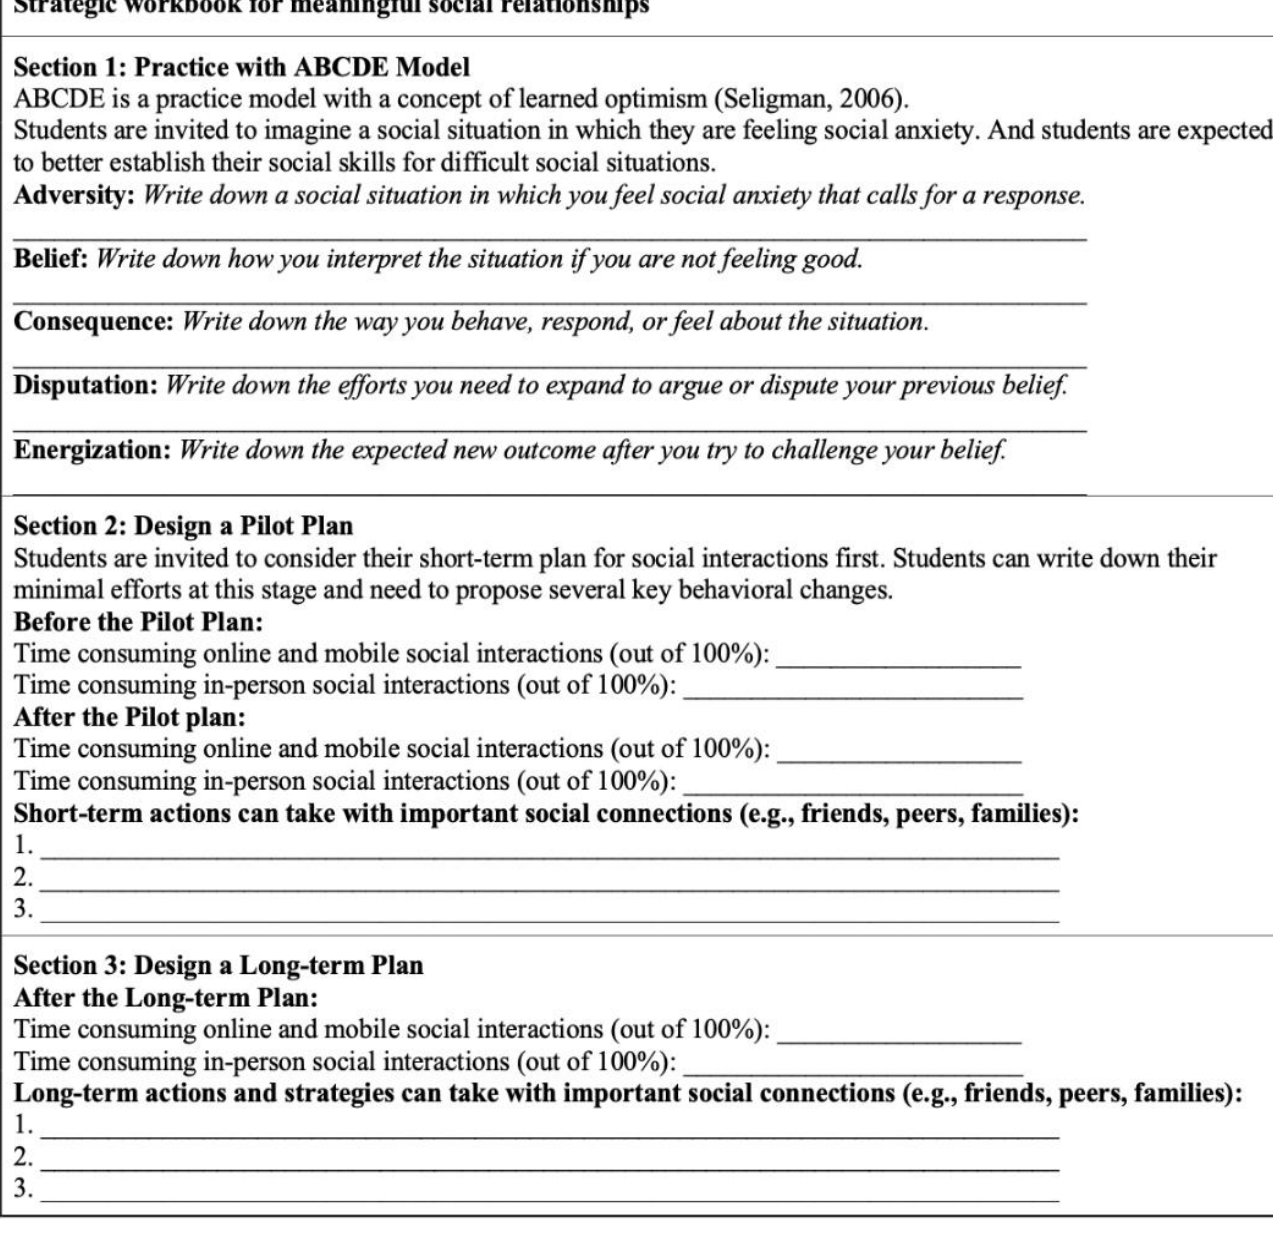
Figure 1. Strategic Workbook Form